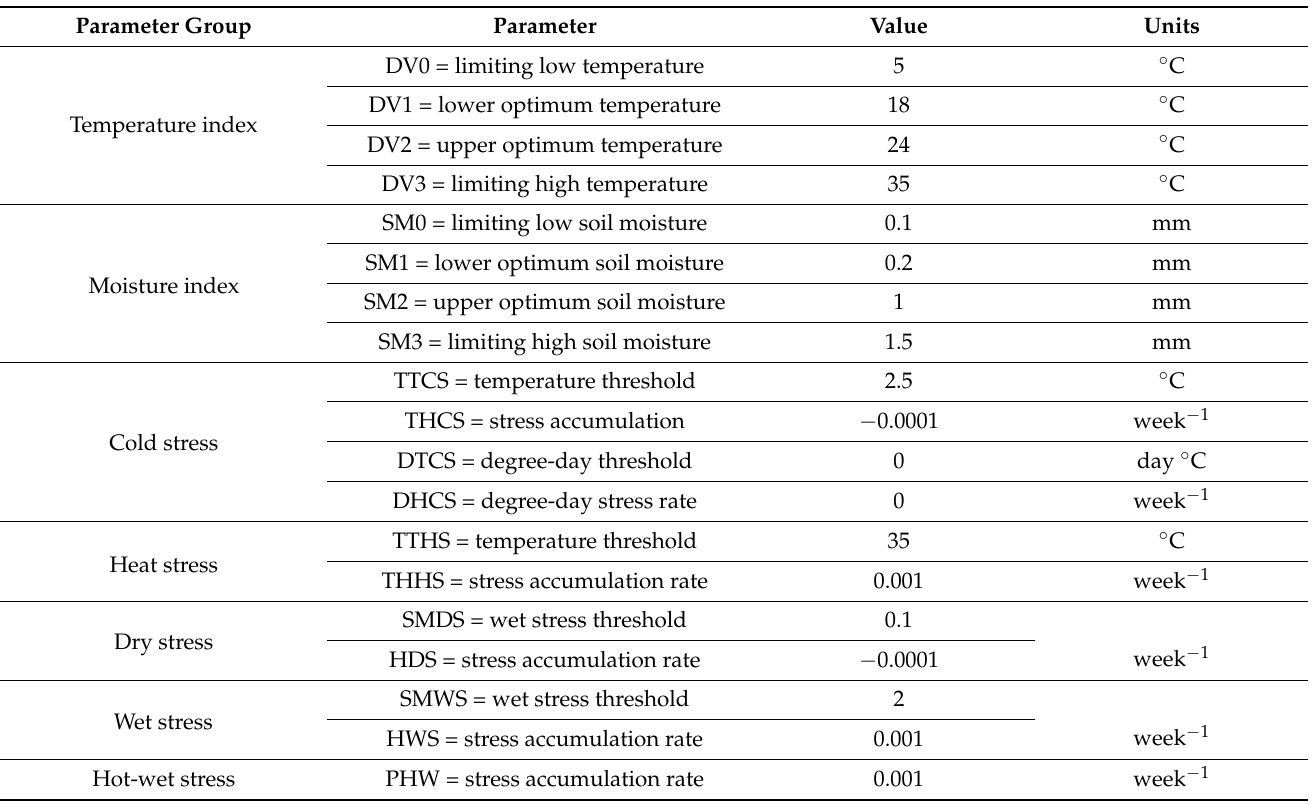
Table 1. CLIMEX parameter values used for modelling the potential distribution of S. madagascariensis